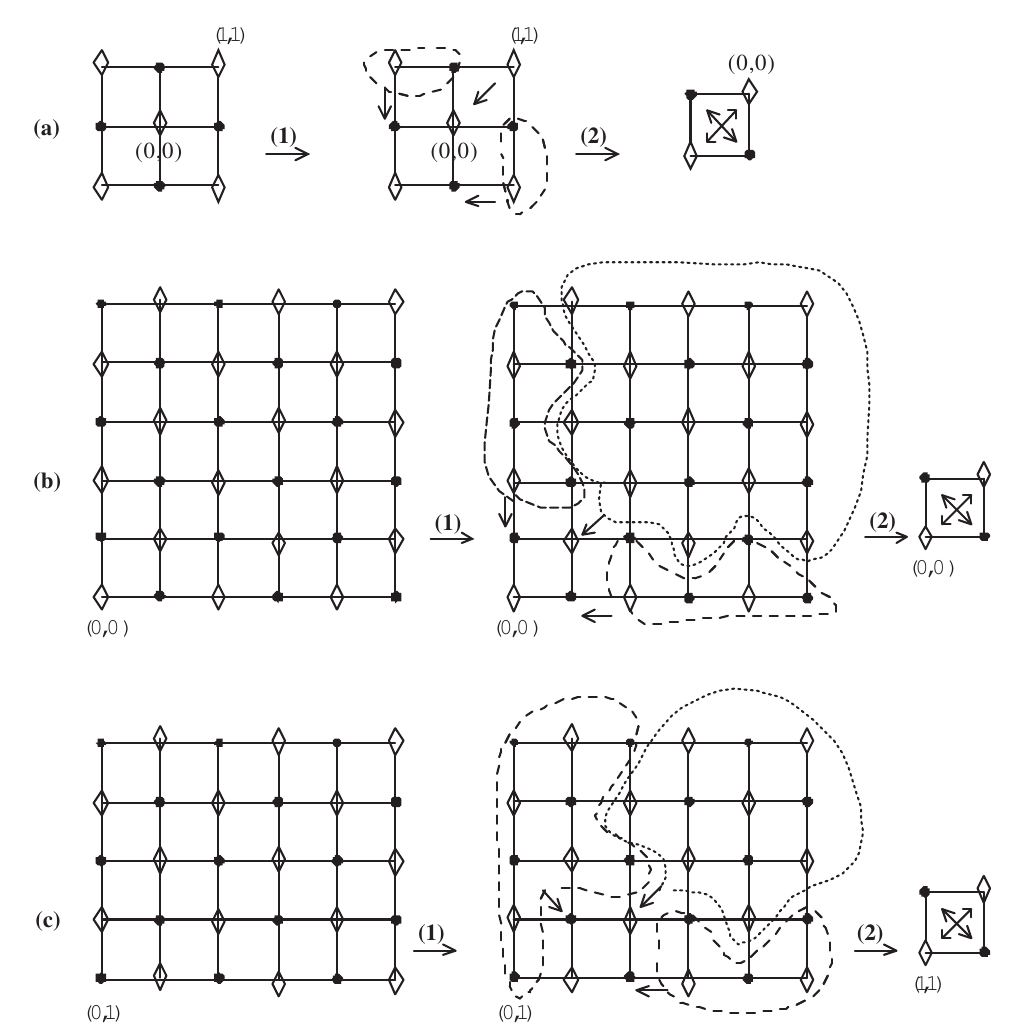
Figure 2. The non- AFPP of an compact M -topological